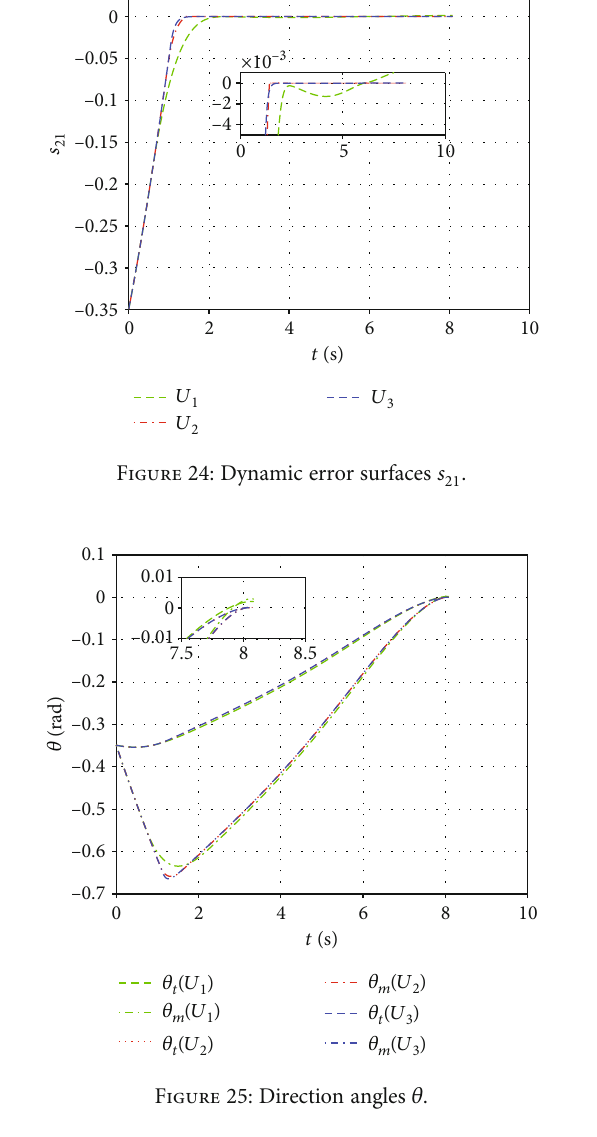
Figure 25: Direction angles θ .